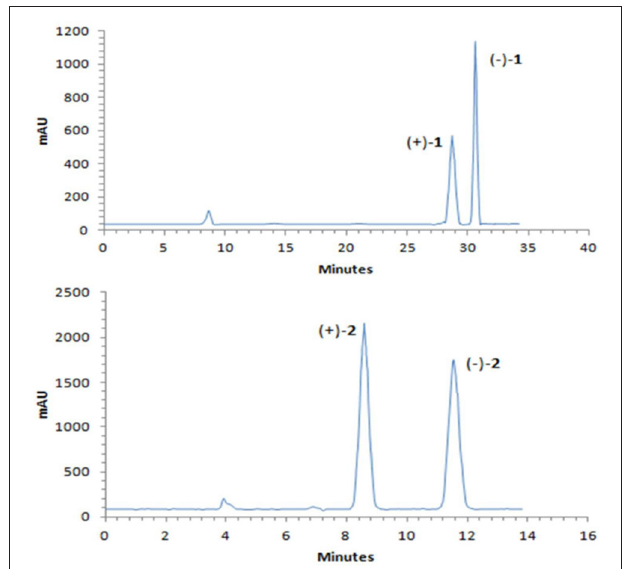
FIGURE 4 | Chiral HPLC separation profiles of ( ± )- 1 and ( ± )- 2 .